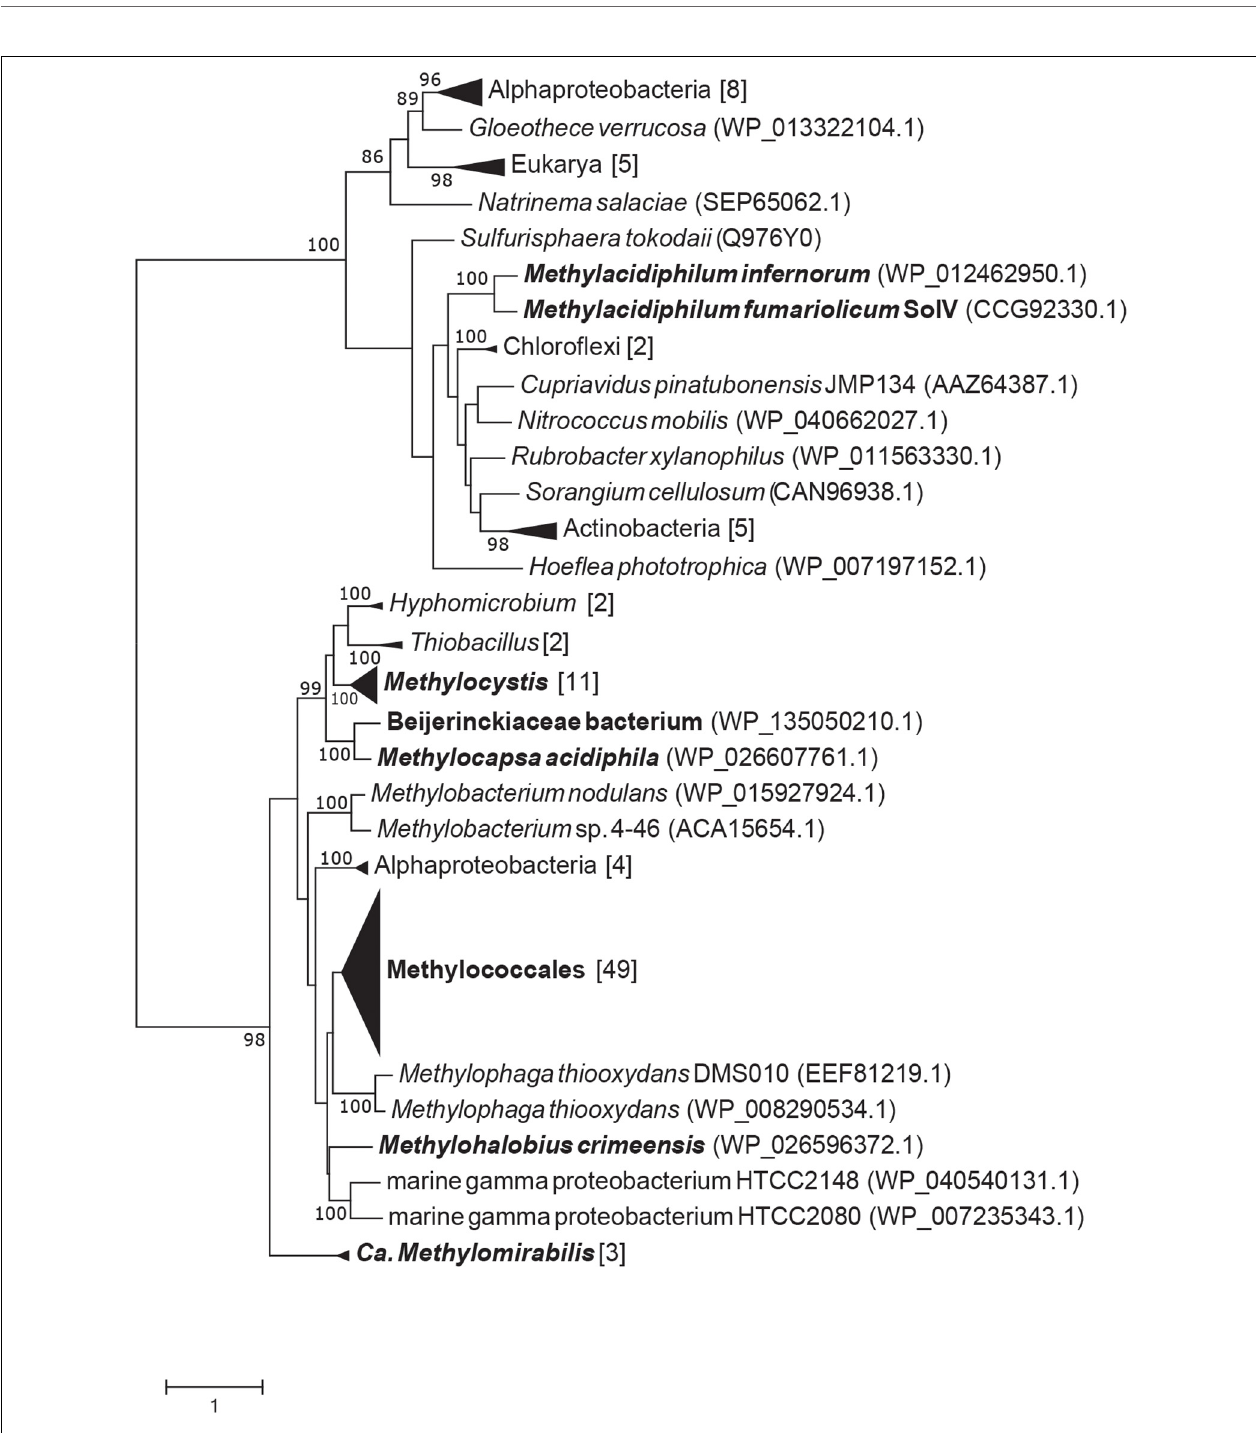
FIGURE 5 | RAxML maximum likelihood tree of putative methanethiol oxidase amino acid sequences from methanotrophs. Bootstrap values above 80 are shown, based on 500 replicates. Black names indicate methanotrophic clades or